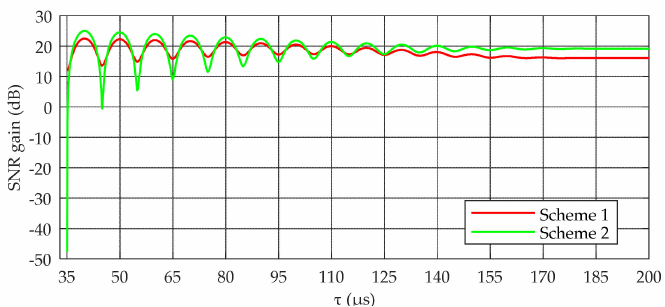
Figure 5. Relationship between signal-to-noise ratio (SNR) gain and τ when λ = 1.6 dB.